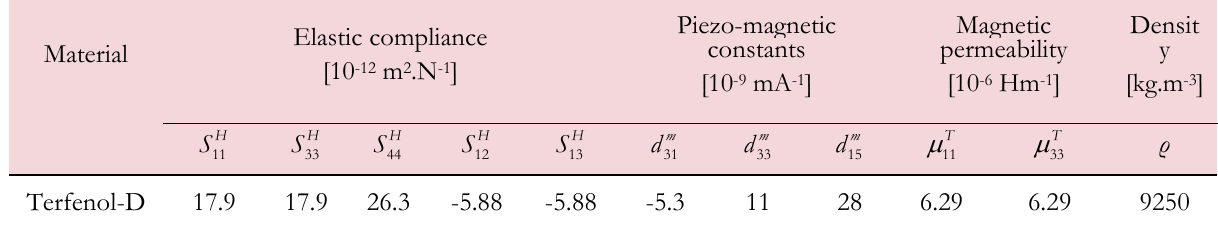
Table 2: Terfenol-D material